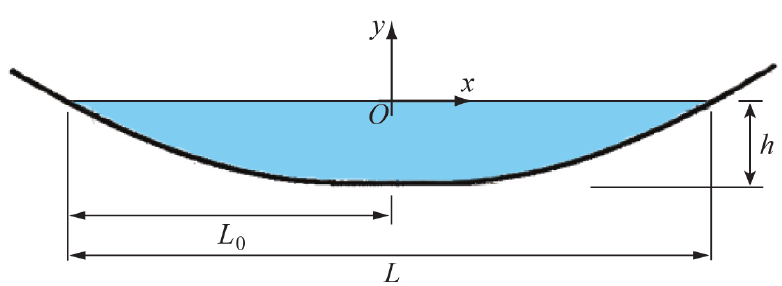
Figure 4. Schematic illustration of a tank with parabolic bottom